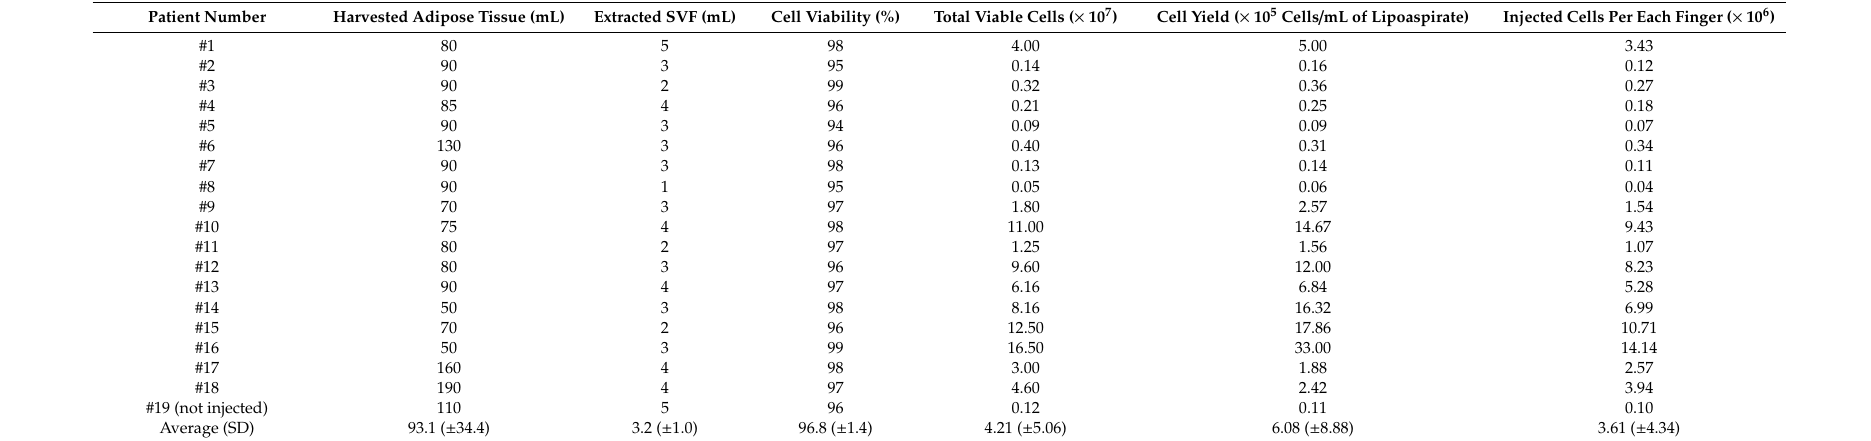
Table 2. Cellular profiles related to SVF